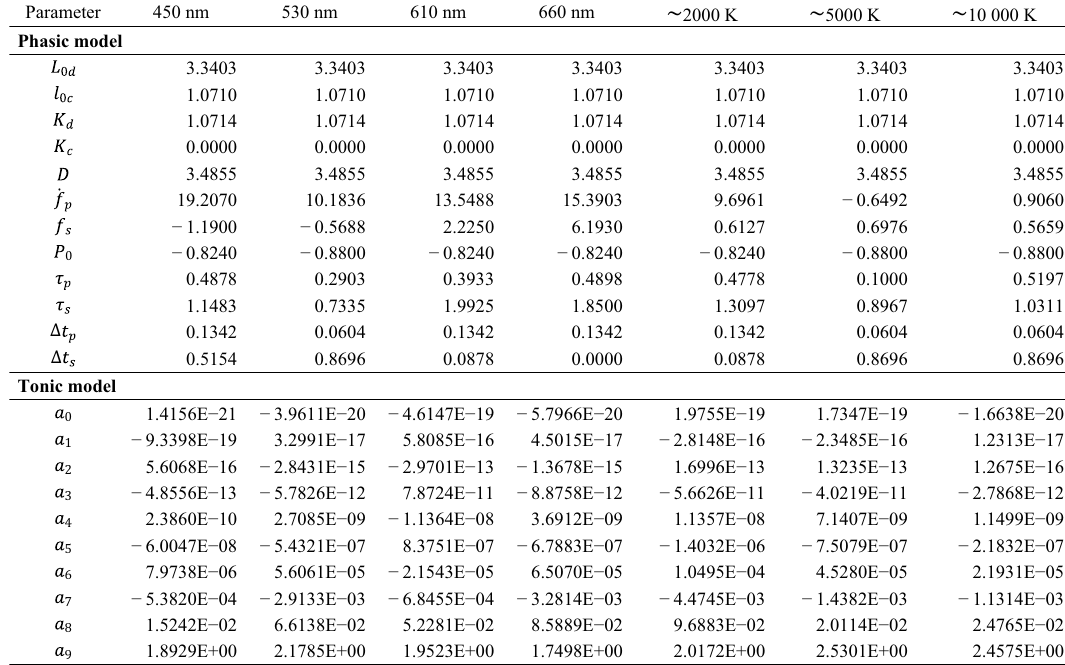
Table 1. Modell parameters of the phasic and tonic pupil model for each lighting condition in the intersubject study. The values were obtained using a custom programmed user interface in MathWorks MATLAB. The phasic model represents the pupil light response up to two seconds. The data of the remaining pupillary light response are mapped with the tonic model. The median of the sample was used as the target. The sample consisted of 20 subjects (Age: 19–25, Mean age: 21.95 ± 1.73 y) in the polychromatic investigation and 20 subjects (Age: 19–25, Mean age: 22.2 ± 1.77 y) in the chromatic investigation. The predicted pupil diameter from the offset corrected Watson and Yellot model was used as r ( 0 ) to solve the differential equation. The mean value of the two age groups with 22.1 y, the luminance of the anchor spectrum with 199.45 cd/m 2 and the size of the adaptation surface with 53.1° were used as parameters in the Watson and Yellot model. An offset of 0.41 mm was subtracted to adjust the model to our data.